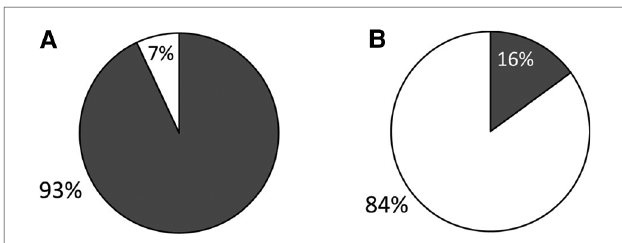
FIGURE 1 Caregiver-reported data on vaccination discussion and administration in IBD and c-SLE. Grey: Subspecialty clinic; White: PCP clinic or local health department. ( A ) Discussion of vaccinations in past year. ( B ) Administration of vaccines in the past